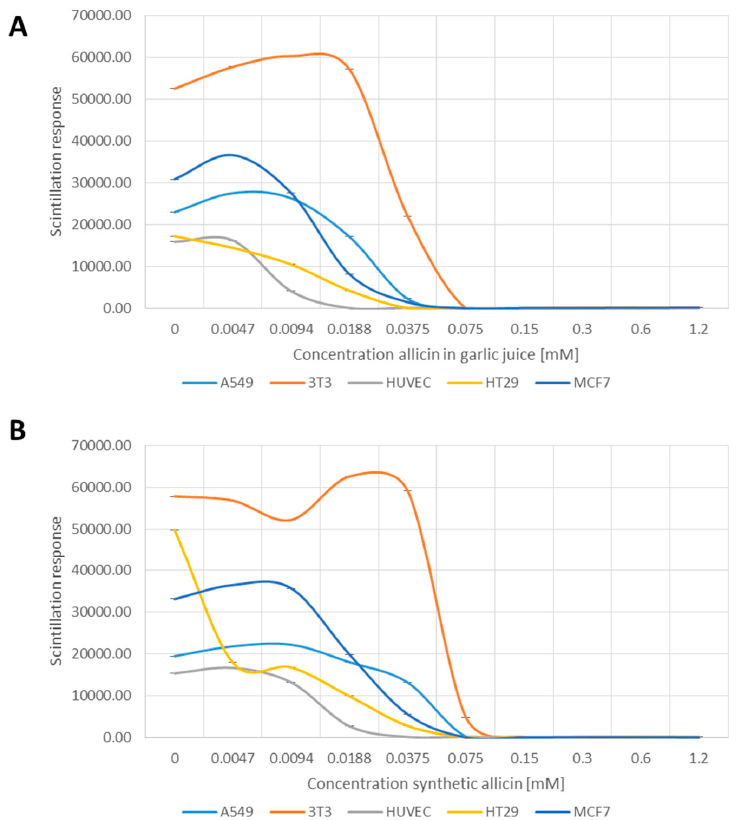
Figure 2. Effect of garlic juice normalized to its allicin concentration ( A ); and synthetic allicin ( B ) on cell proliferation as tested by incorporation of 3 H labelled thymidine in DNA and measured by scintillation. All data points are means of three replicates; error bars show standard deviation.